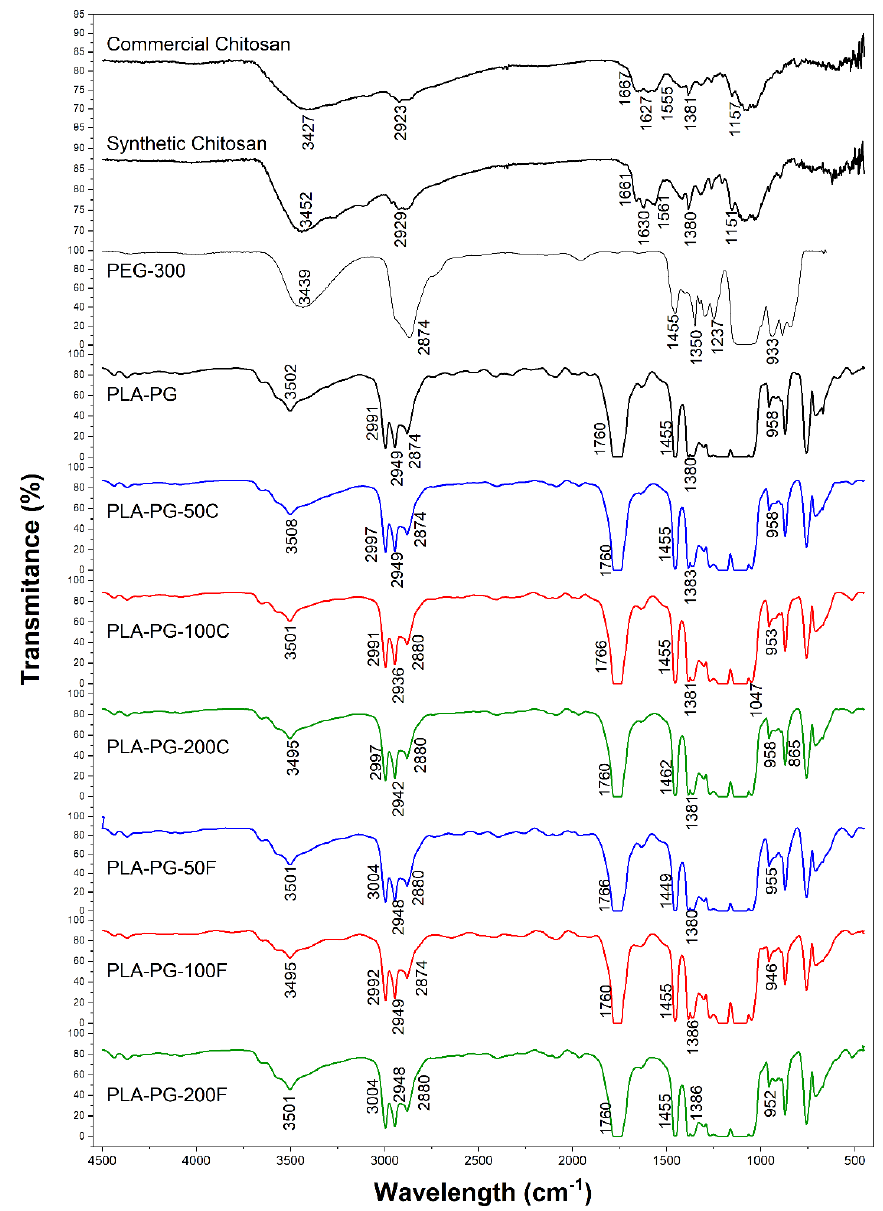
Figure 1. FTIR spectra of commercial and synthetic chitosan, PEG300, PLA ‐ PG film and their different formulations.